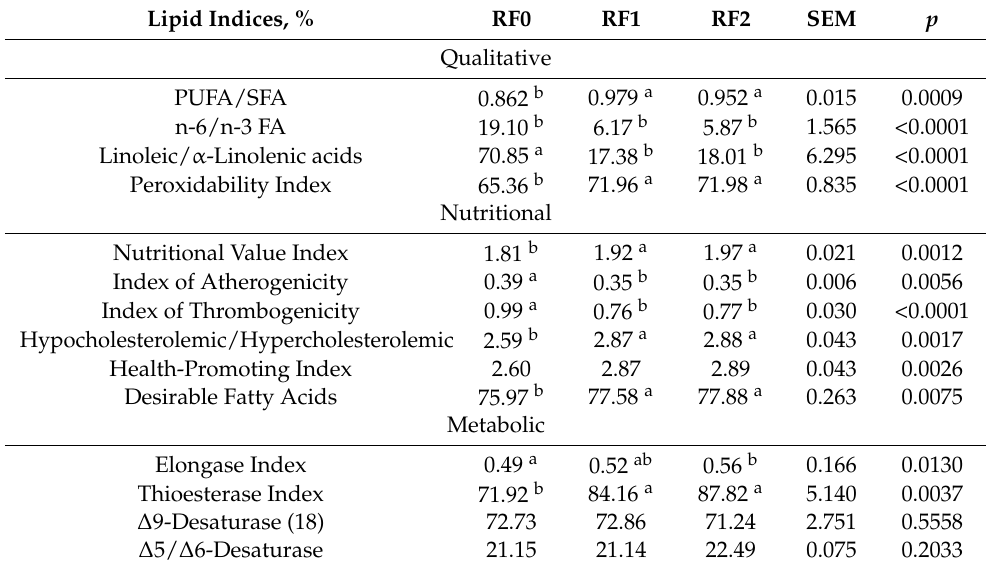
Table 7. Estimation of lipid quality indices of egg yolk based on their nutritional classes. Lipid Indices, % RF0 RF1 RF2 SEM p